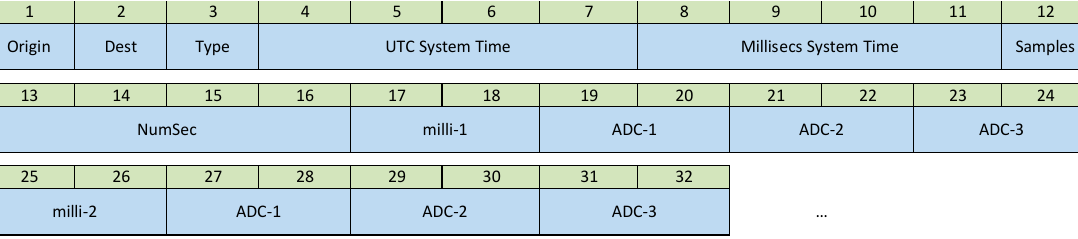
Figure 5. Structure of the Samples Reply message.